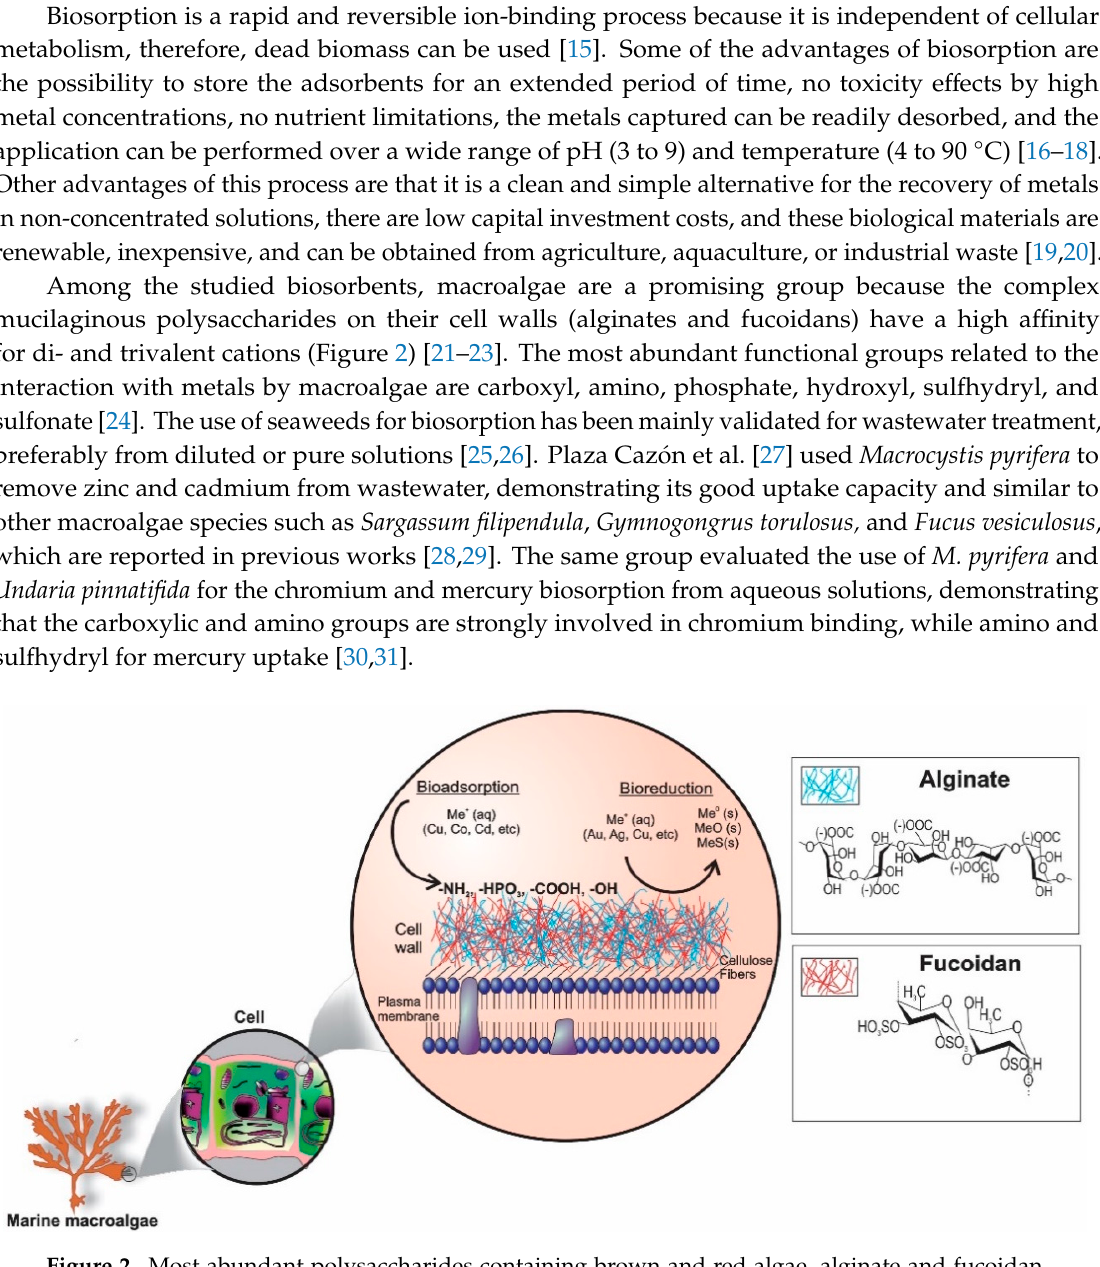
Figure 2. Most abundant polysaccharides containing brown and red algae, alginate and fucoidan, which are related to the metal biosorption